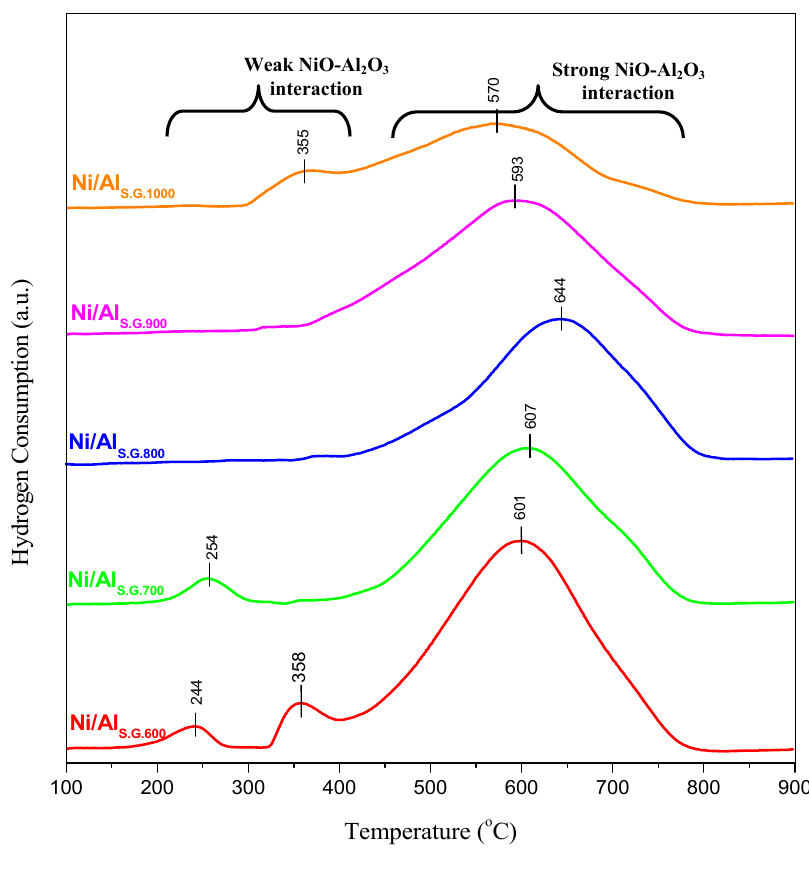
Figure 3. Temperature-programmed reduction (TPR) profiles of nickel/sol gel alumina